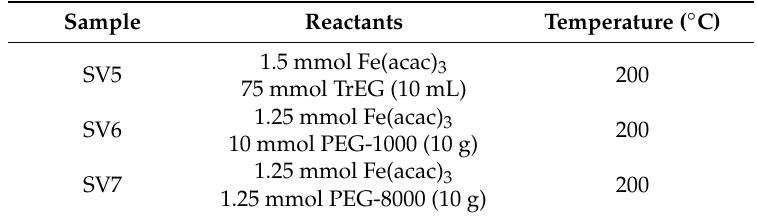
Table 2. Synthetic parameters of the solvothermally produced samples, SV5, SV6, and SV7.